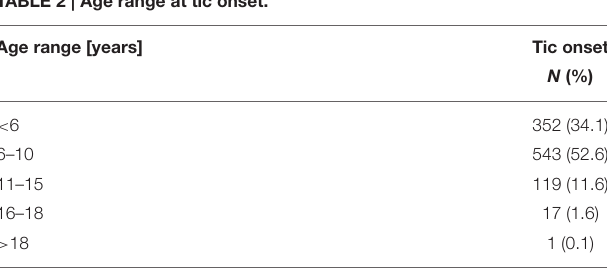
TABLE 2 | Age range at tic onset.